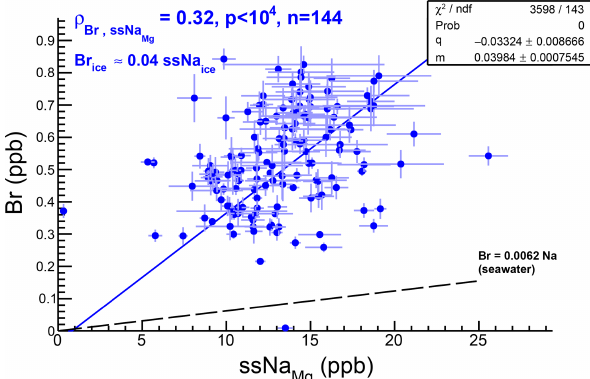
Figure C1. Correlation between bromine and ssNa Mg concentra- tions in the glacial section of the RECAP ice core. The weak pos- itive correlation suggests a common source for the two elements. The slope of the (qualitative, p ( χ 2 ) ∼ 0) linear fit indicates sig- nificant ( ∼ 6) enrichment compared to seawater mass ratios (black